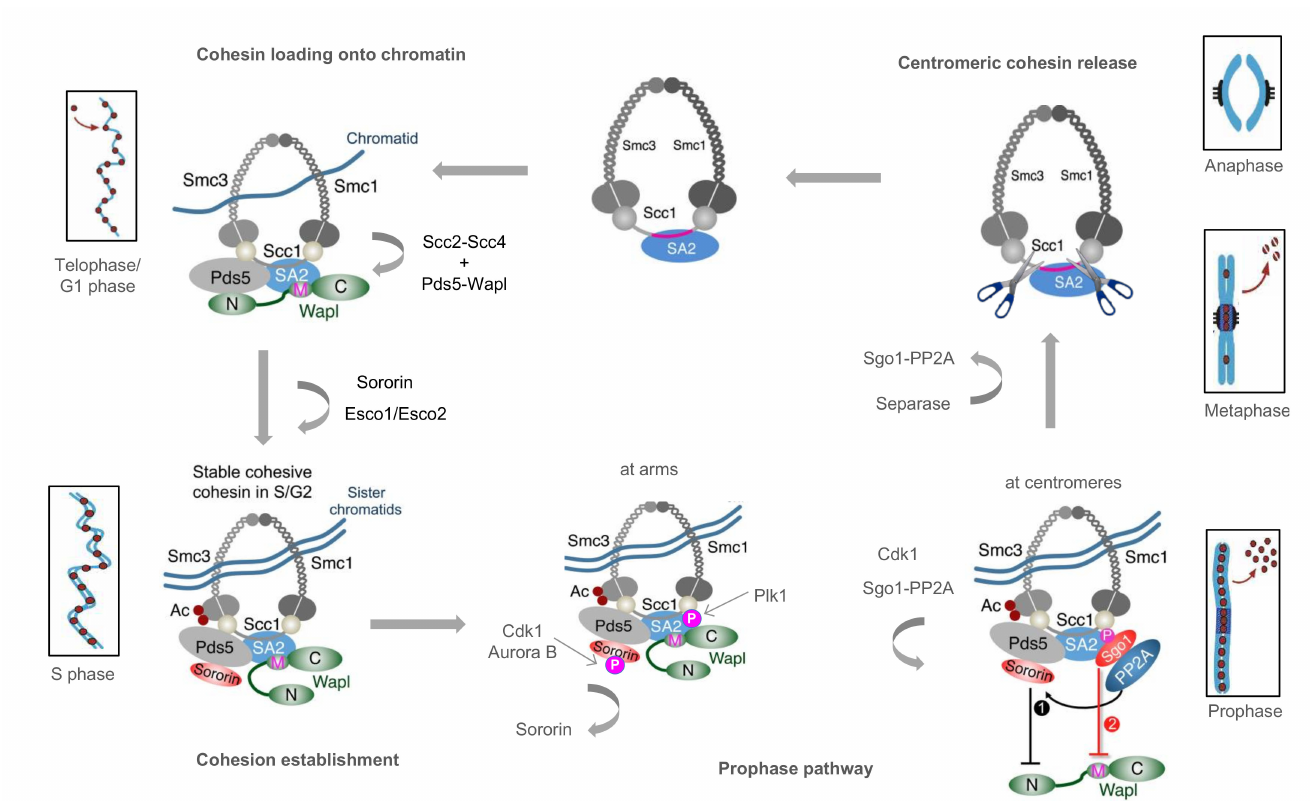
Figure 1. Cohesin cycle in human cells. The cohesin loader, Scc2-Scc4, and unloader, Pds5-Wapl, promote dynamic association of cohesin to chromatin in telophase and G1. During S phase, Smc3 acetylation and Sororin binding stabilize cohesin association to chromatin. Sister chromatids are entrapped by cohesin rings at the replication forks and cohesion is established. In prophase, cohesin bound to chromosome arms is released by Wapl-Pds5 following phosphorylation of Sororin (“prophase pathway”). In contrast, cohesin bound at the centromeres is protected by Shugoshin (Sgo1) and protein phosphatase 2A (PP2A) against the releasing activity of Wapl. At the metaphase-anaphase transition, Shugosin-PP2A dissociates from cohesin. Thus, in anaphase cohesin can be cleaved by Separase to enable chromosome segregation. Cohesin drawing has been inspired by [10] with